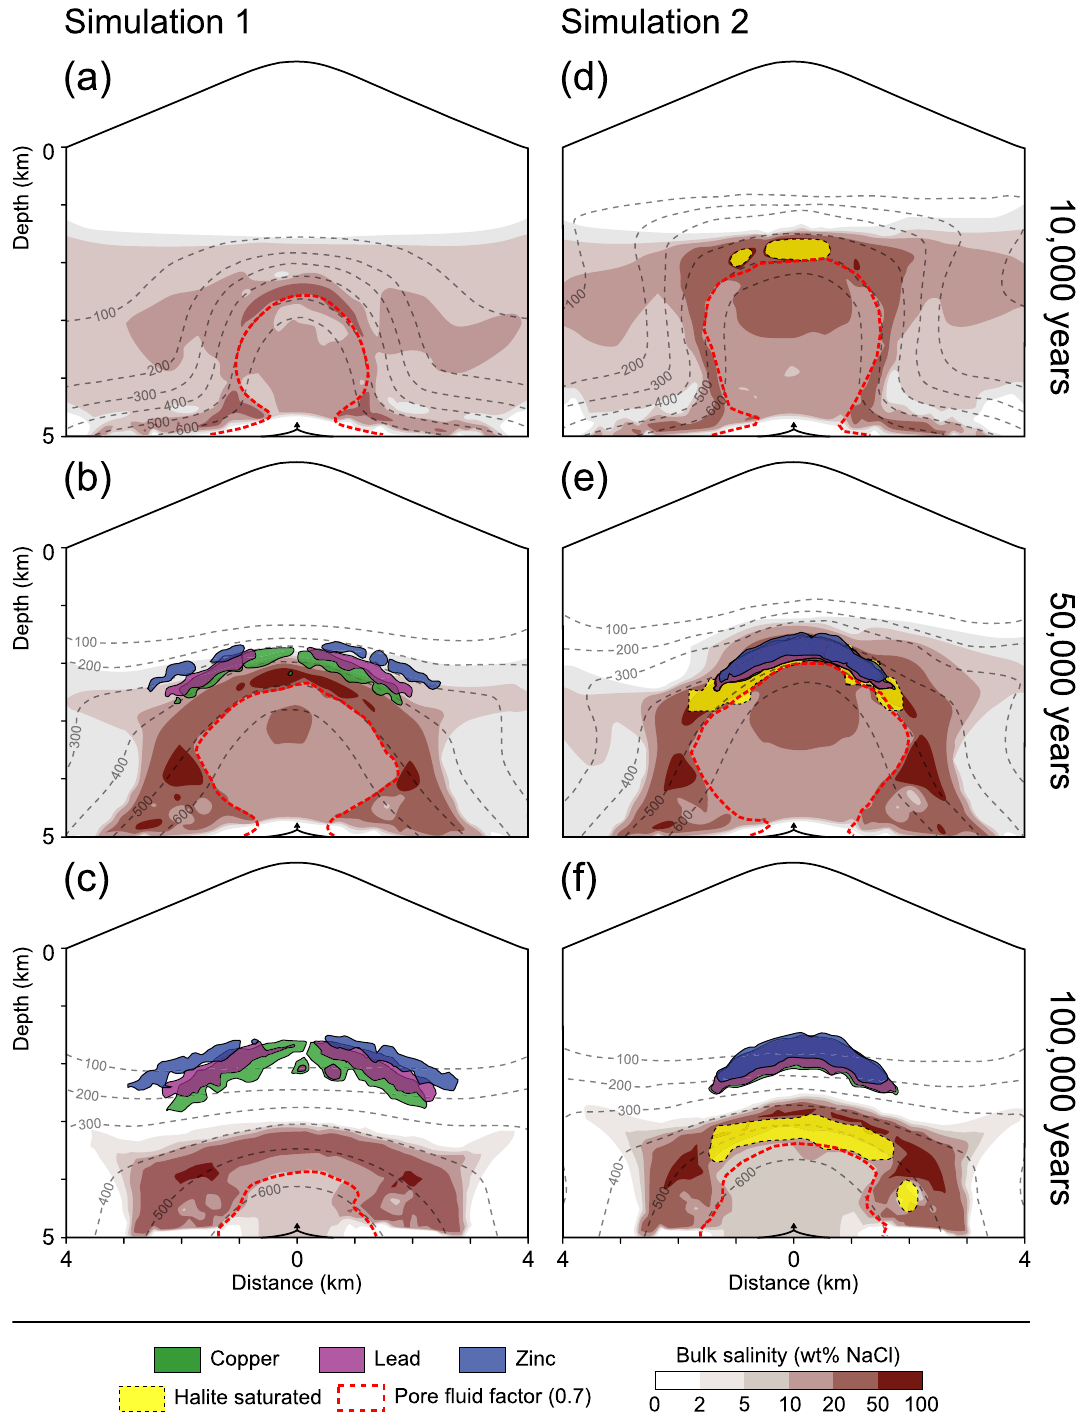
Figure 2. Temporal and spatial evolution of the hydrology of porphyry copper systems with a volcano topography after 10 ( a , d ), 50 ( b , e ) and 100 ( c , f ) kyrs of simulation time, showing modeled temperature distributions (isolines), the bulk salinity of the fluid mixture (red colors) and the region with halite-saturated fluids (yellow). Ore shells are represented by metal enrichment potentials (see text). The pore fluid factor (fluid pressure divided by lithostatic pressure) of 0.7 indicates the transition from near-hydrostatic to near-lithostatic fluid pressures. Simulation 1 used a radial factor of 0.25 and metal enrichment potentials of 250 for Cu, Zn and Pb ( a–c ). Simulation 2 used a radial factor of 0.5 and metal enrichment potentials of 500 ( d – f ). Arrows at a depth of 5 km refer to the fluid injection location at the cupola region of the magma